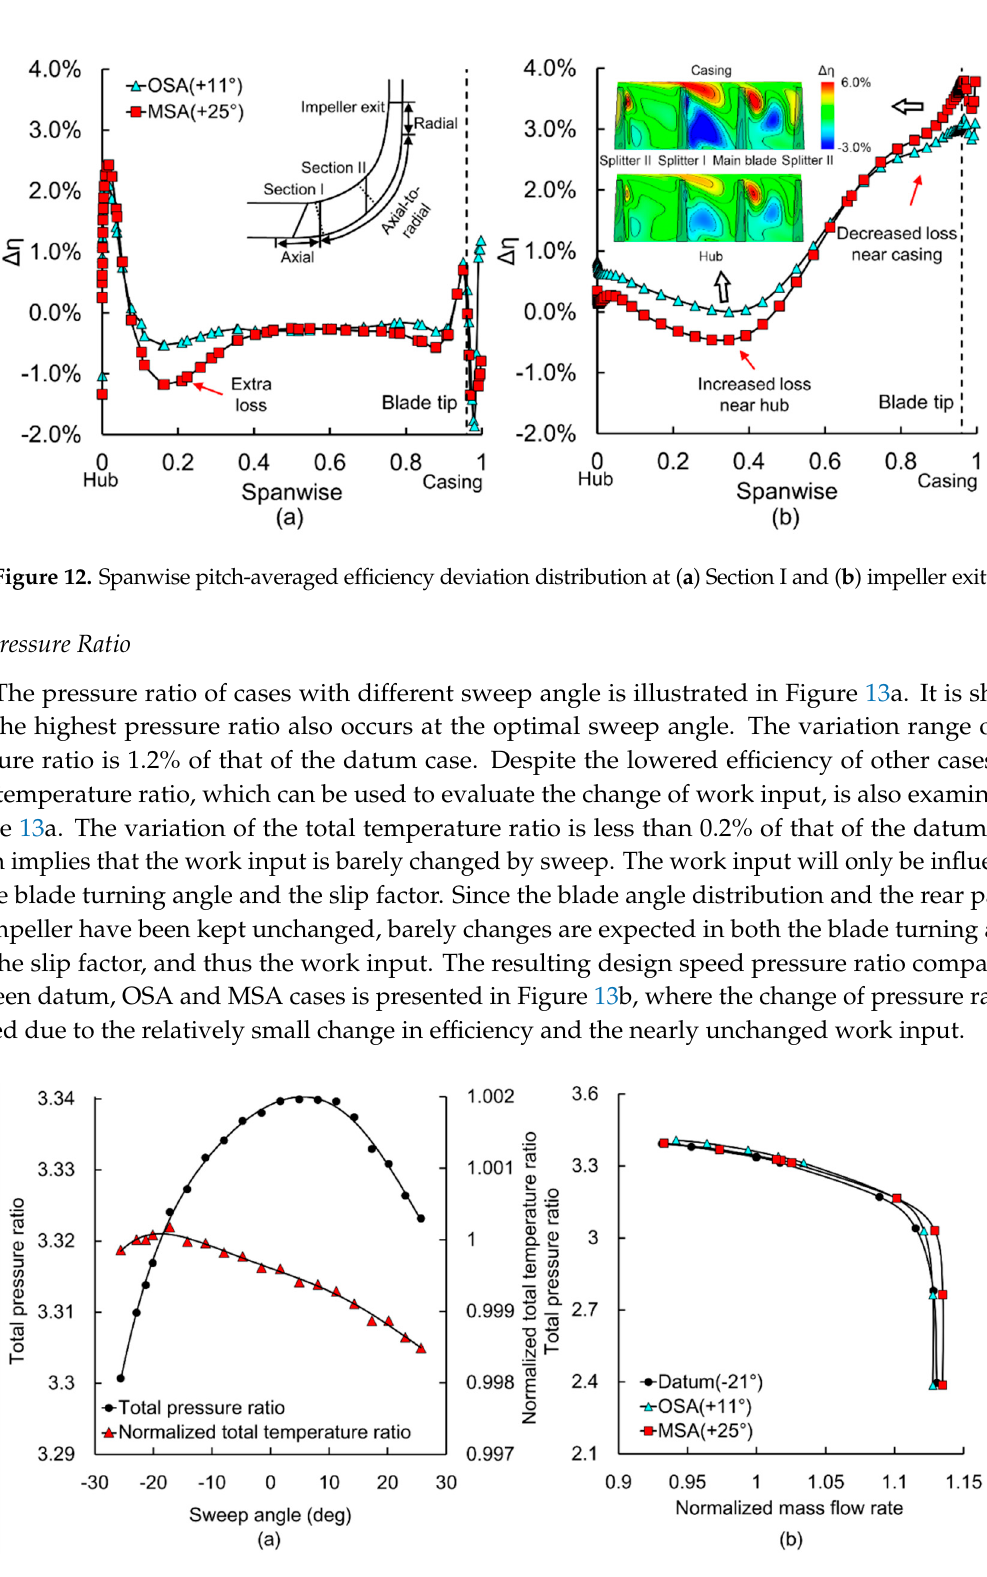
Figure 13. Pressure ratio: ( a ) trend with sweep angle and ( b ) design speed performance comparison.